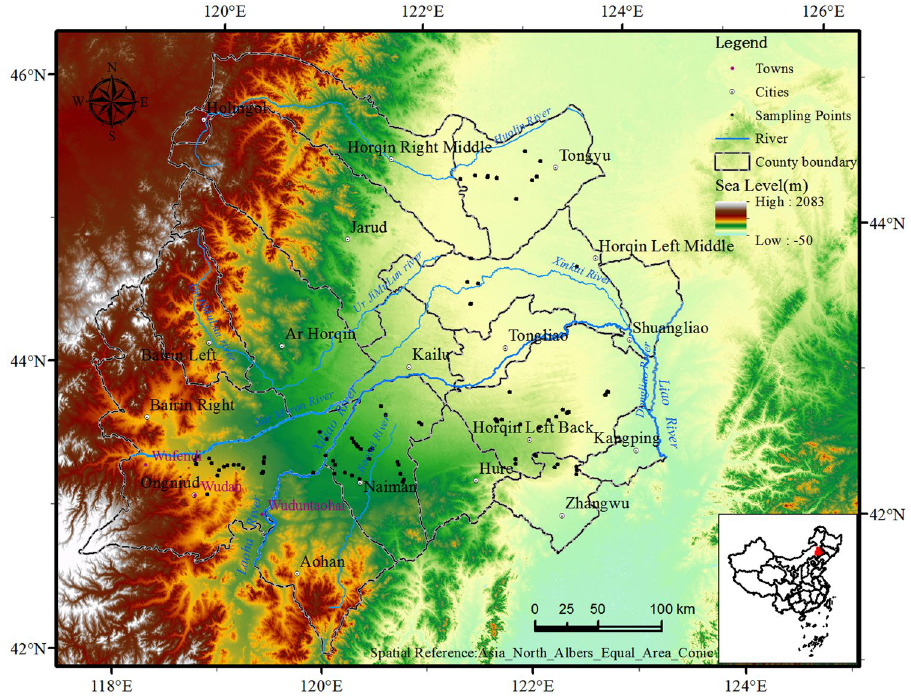
Figure 4. Location of the study area. The maps were generated by ArcGIS software (Version 10.0, ESRI, Redlands, CA, USA,